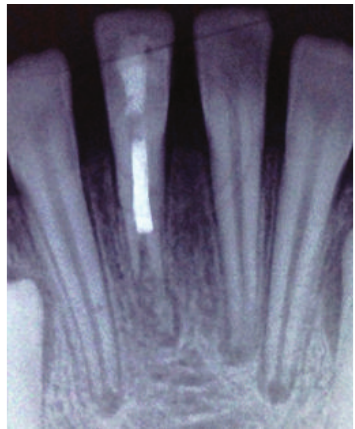
Figure 4: Root canal was filled using a calcium hydroxide and iodoform paste (Metapex).